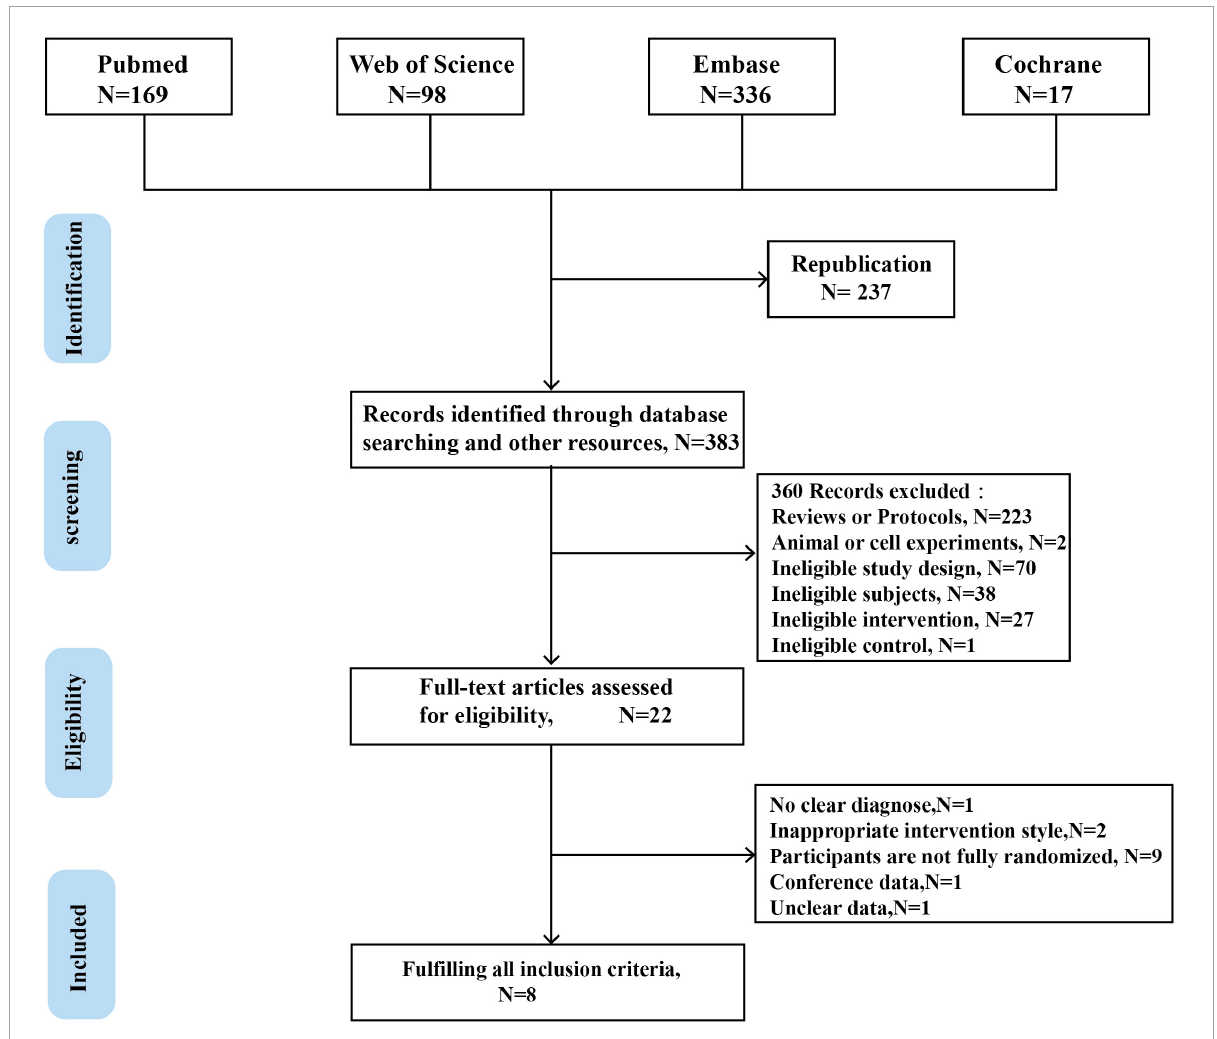
FIGURE1 PRISMA flow chart. Showing the article selection process. Eight chosen